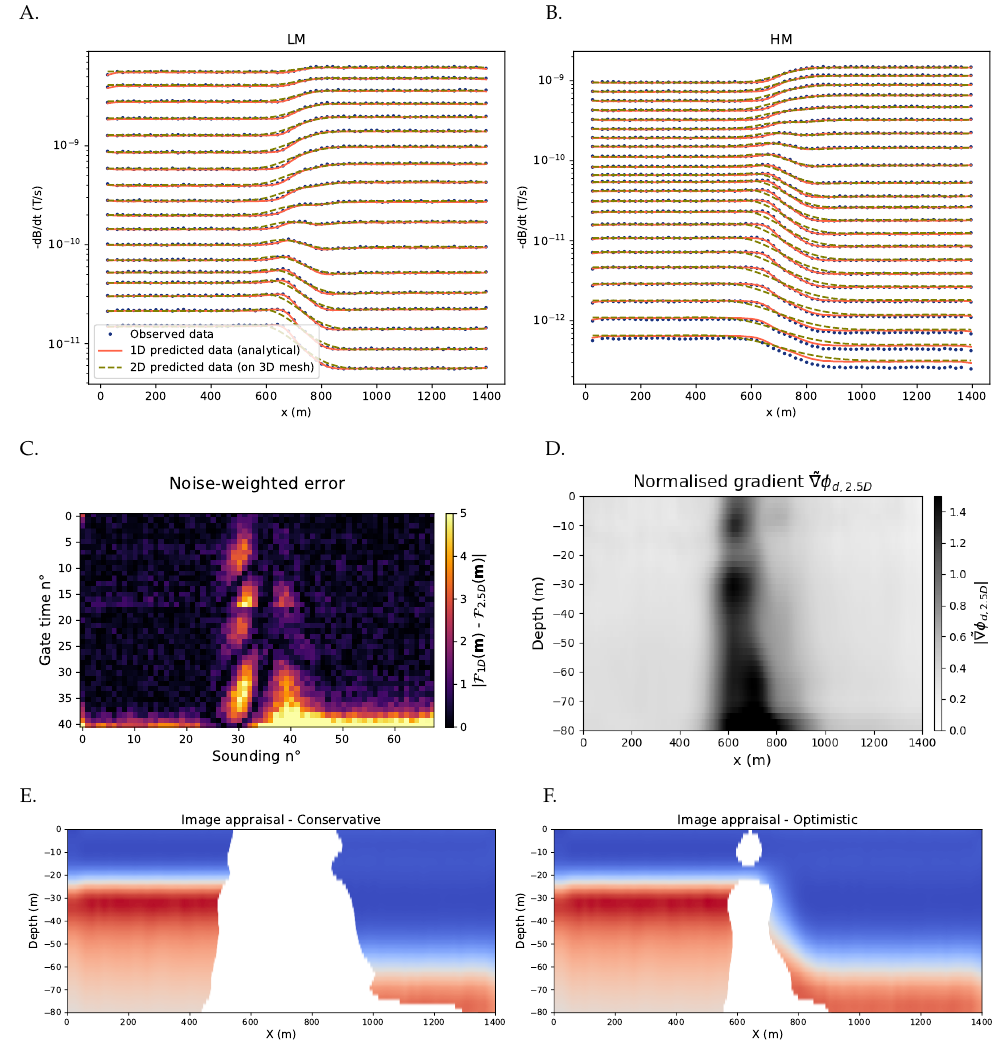
Figure 3. Image appraisal with perfect forward modeling. ( A , B ) A discrepancy mainly near the x = 700 m interface. ( C ) The individual noise-weighted errors. The first 18 gate times correspond to the LM and the 23 last gate times to the HM. ( D ) The normalized gradient indicates areas near the x = 700 m interface. ( E , F ) Image appraisal outcomes clearly indicate problematic areas in the region near the